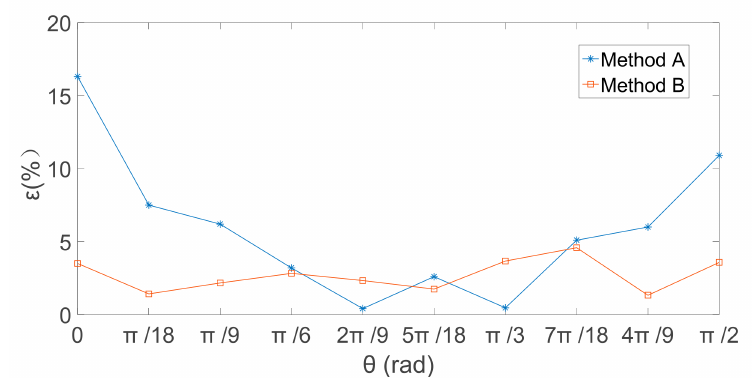
Figure 11. Relative Error in Electric field intensity ( ε